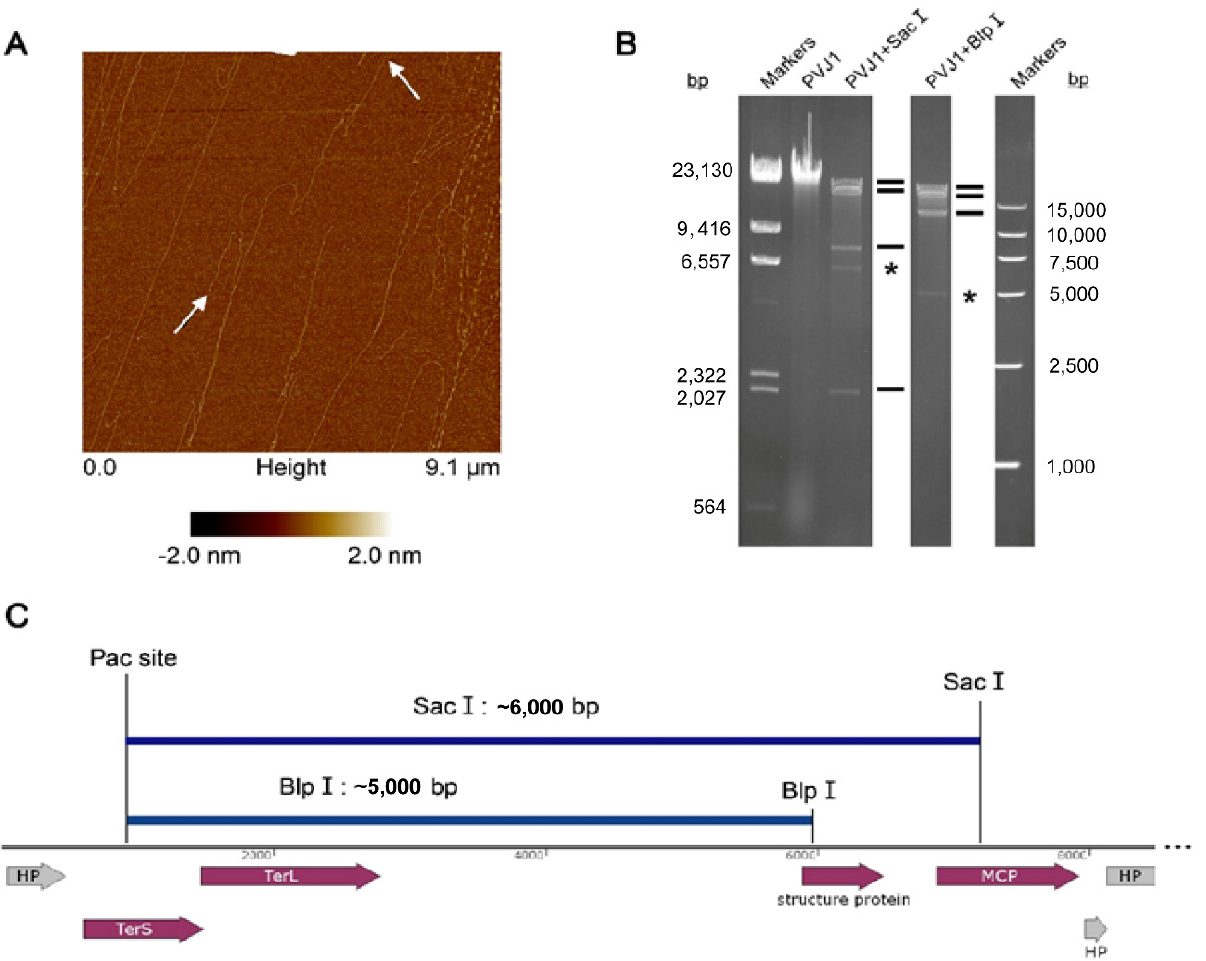
Figure 5. Analysis of the structure of the PVJ1 genome: ( A ) AFM images of the purified genomic DNA of PVJ1. White arrows point to the two ends of the linear genome; ( B ) restriction digestion of the PVJ1 DNA. The purified PVJ1 DNA was digested with either BlpI or SacI. The restriction fragments were subjected to electrophoresis in 0.8% agarose gel. The gel was stained with ethidium bromide and photographed under UV light. Expected restriction fragments are shown by thick horizontal lines. The pac fragments generated by SacI and BlpI cleavage are indicated with a star (*); ( C ) a diagram showing the sizes of the pac fragments generated through packaging initiation cleavage and restriction cleavage with SacI and